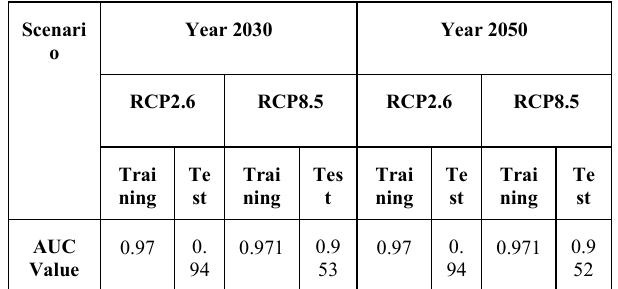
The potential distribution maps were categorized into four categories based on suitability; highly suitable (>60%), moderately suitable (60%-40%), Low suitable (40%-20%) and unsuitable (<20%)(Zhang et al., 2018). Table 4 and 5 shows the potential habitat area of water hyacinth in the major lakes of Nepal in current and future scenario under RCP 2.6 and 8.5.